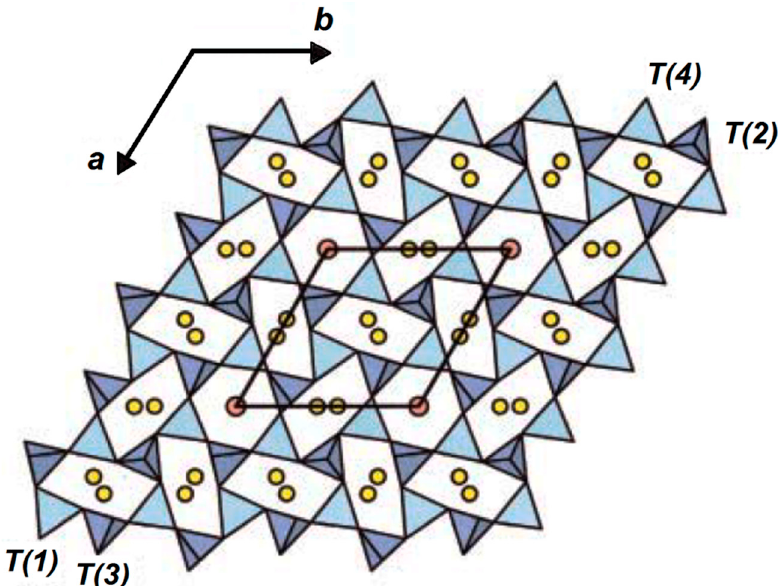
Figure 2. The crystal structure of the nepheline projected onto (001). The T(2) and T(3) tetrahedra (Si > Al) are navy blue, the T(1) and T(4) tetrahedra (Al > Si) are greenish blue, the K sites are shown as orange spheres, and the Na sites, as yellow spheres. Reproduced with permission from [5], published by The Canadian Mineralogist, 2003.